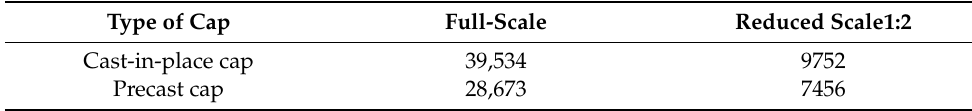
( b ) Figure 23. Summary of the M − N diagram. ( a ) Bottom plate thickness is 0.5 m; ( b ) bottom plate thickness is 0.8 m.